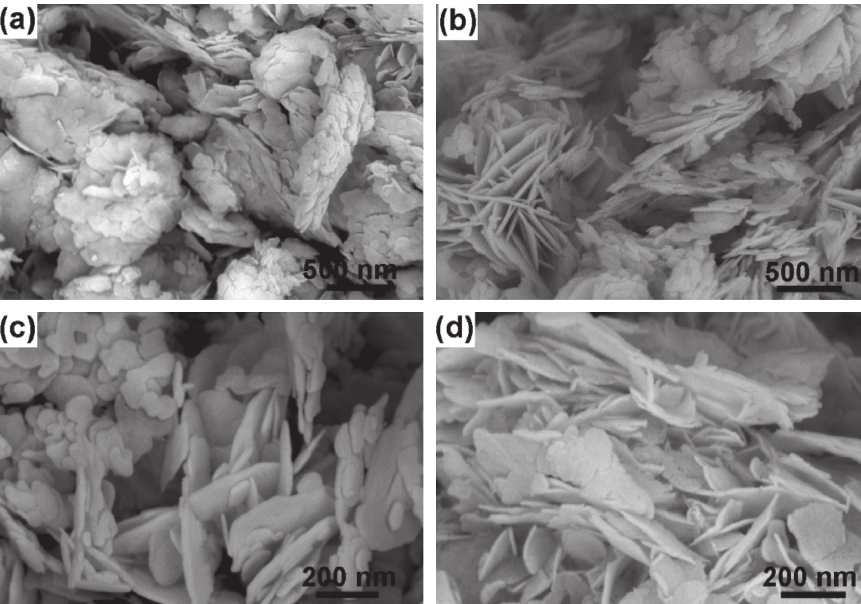
Figure 7: SEM images of ordinary BiOCl (a, c) and ultrathin BiOCl (b, d)